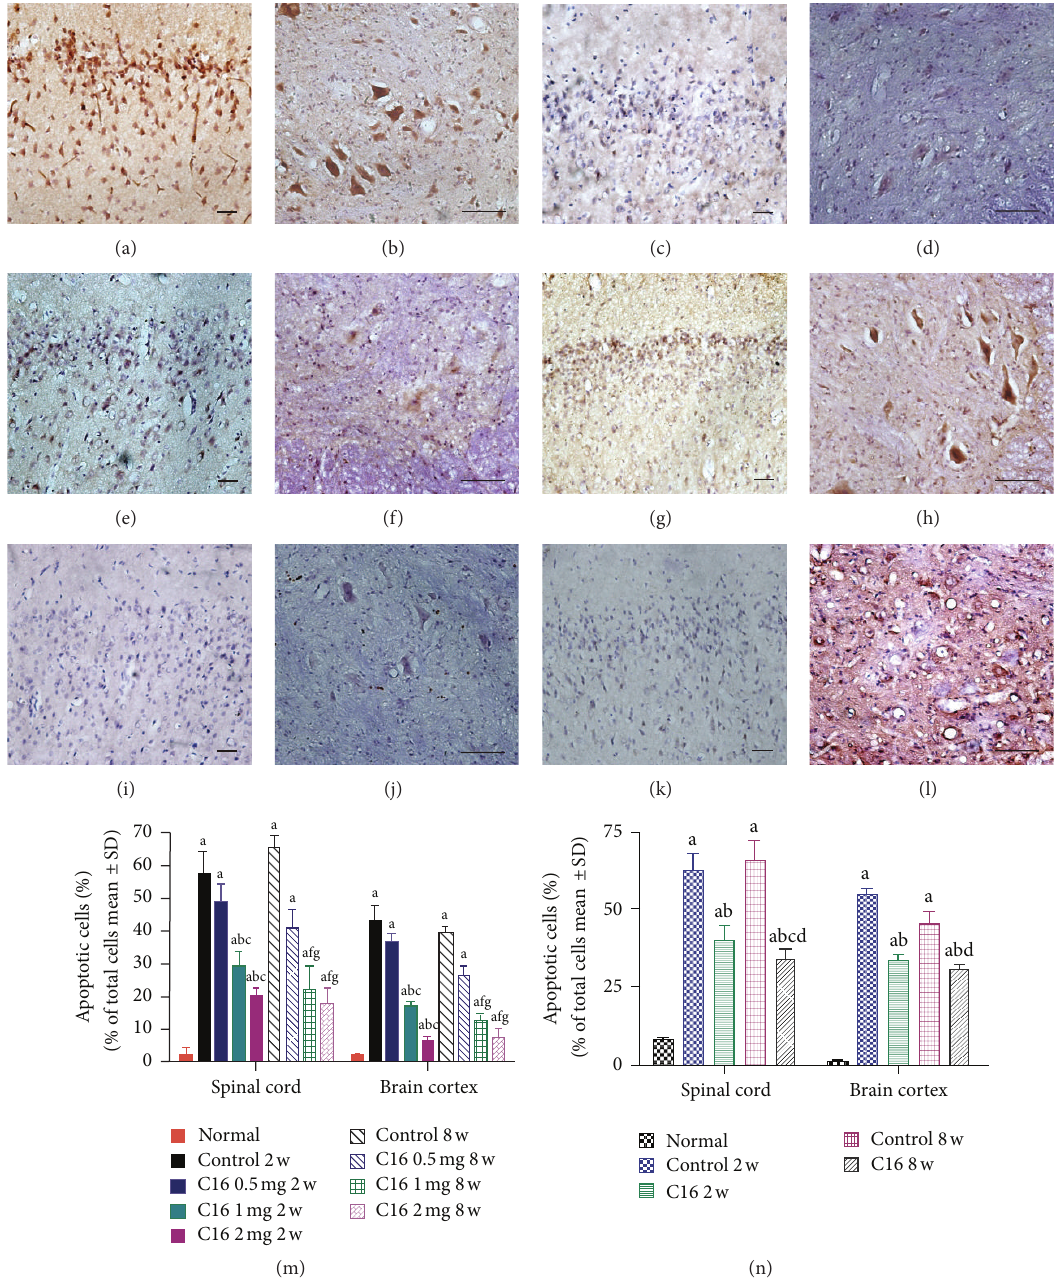
Figure 10: C16 treatment reduced the apoptotic neural cells in spinal cord and brain. Caspase-3 immunostaining, counterstained with hematoxylin; bar = 100 𝜇 m. ((a), (c), (e), (g), (i), and (k) coronal sections of motor cortex; (b), (d), (f), (h), (j), and (l) traverse section through the lumbar spinal cord). At week 2 post-immunization, vehicle control rats ((a) large numbers of caspase-3 labeled apoptotic neural cells appeared in the hindlimb area of motor cortex) and ((b) plenty of caspase-3 labeled apoptotic neural cells appeared in the anterior horn of spinal cord) 2mg/per day C16 treated EAE rats ((c), (d)). C16 late treated EAE rats ((e), (f)). At week 8 post-immunization, vehicle control rats ((g), (h)), 2 mg/per day C16 treated EAE rats ((i), (j)), and C16 late treated EAE rats ((k), (l)). (m) Medium to high-dose C16 treatment reduced the number of caspase-3 + apoptotic neural cells. a 𝑃 < 0.05 versus normal rats; b 𝑃 < 0.05 versus vehicle control rats at week 2 postimmunization group; f 𝑃 < 0.05 versus vehicle control rats at week 8 after immunization. g 𝑃 < 0.05 versus 0.5 mg/per day C16 treated EAE rats at week 8 after immunization. (n) Late treated C16 treatment also decreased caspase-3 + apoptotic neural cells to a certain extent. a 𝑃 < 0.05 versus normal rats; b 𝑃 < 0.05 versus vehicle control rats at week 2 postimmunization group; c 𝑃 < 0.05 versus C16 treated EAE rats at week 2 postimmunization group; d 𝑃 < 0.05 versus vehicle control rats at week 8 after